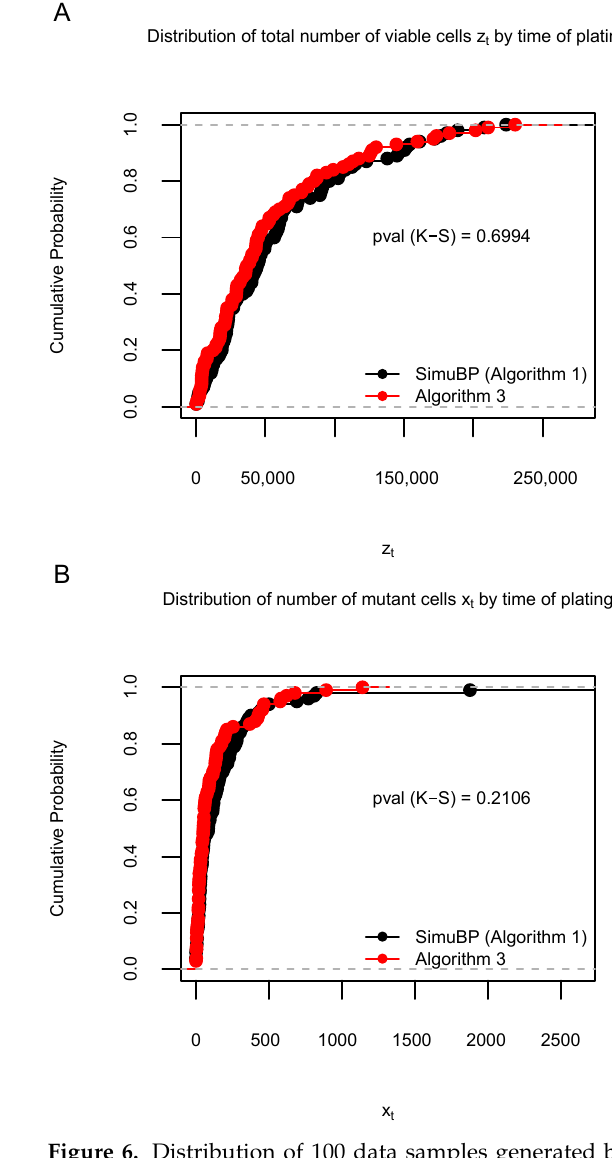
Figure 6. Distribution of 100 data samples generated by Algorithms 1 and 3 in Simulation S2b. ( A ): Empirical cumulative distribution function (ECDF) of the total number of viable cells z t when the time of plating t p = 11. ( B ): ECDF of the number of mutant cells x t when t p = 11. The